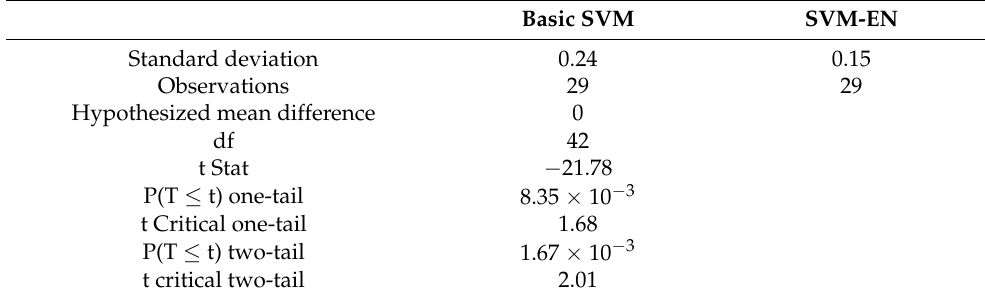
Table A8. t -Test: two-sample assuming unequal variances between basic SVM and SVM-EN, RC